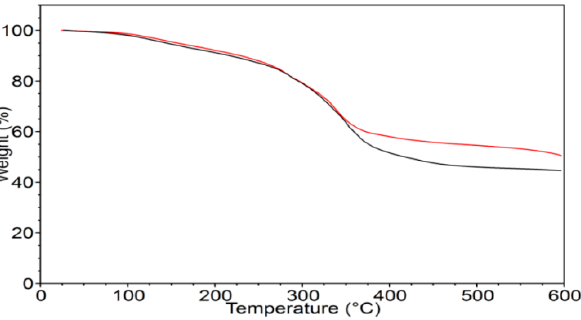
Figure 2. Thermogravimetric (TGA) curves of γ‐ PGA in nitrogen (black curve) and in air (red curve).